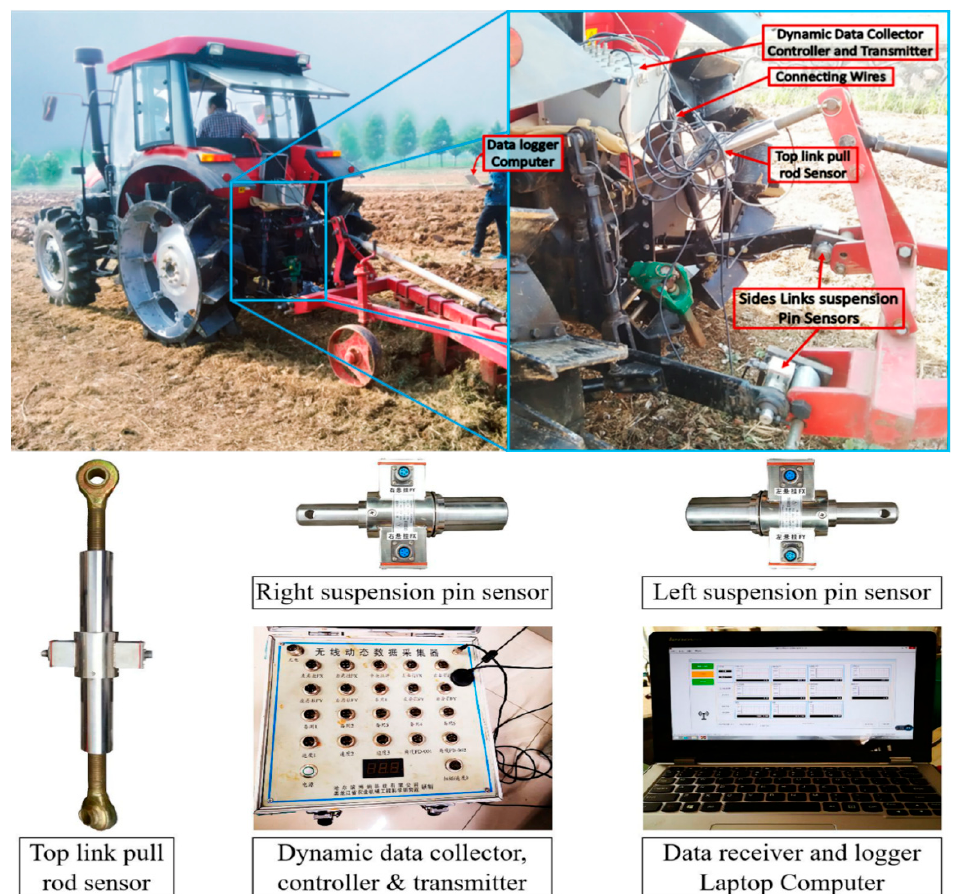
Figure 1. Tractor, tillage implement and test instrument setup for field traction test with rigid lugged wheel (RLW) as a traction device. Table 3. Specifications of tractor and drive wheels. Table 4. Moldboard plow